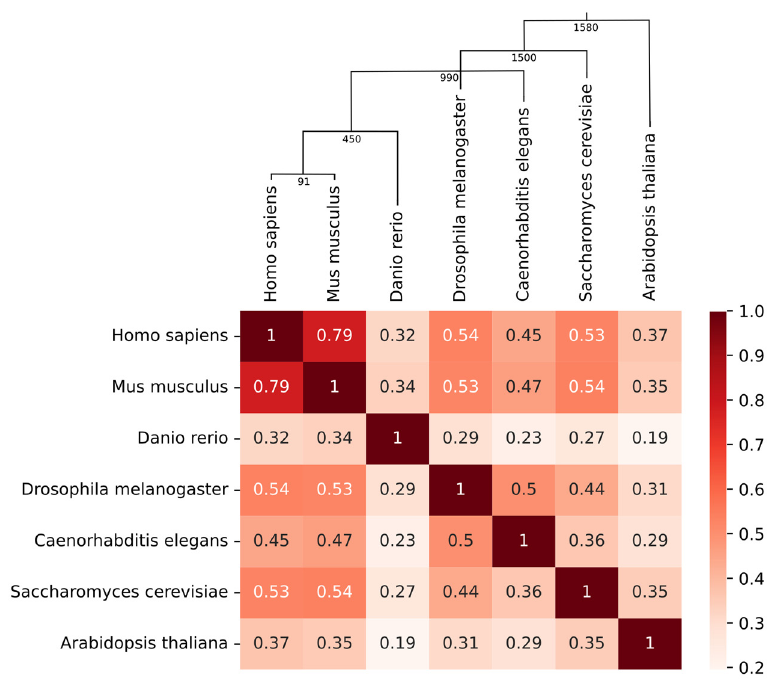
Figure 2. A heatmap illustrating the Spearman correlation between the phosphorylation rate of holologous proteins. At the top of the heatmap, the phylogenetic tree of the seven species is drawn. Times of divergence (million years ago) are indicated at the nodes in the tree.